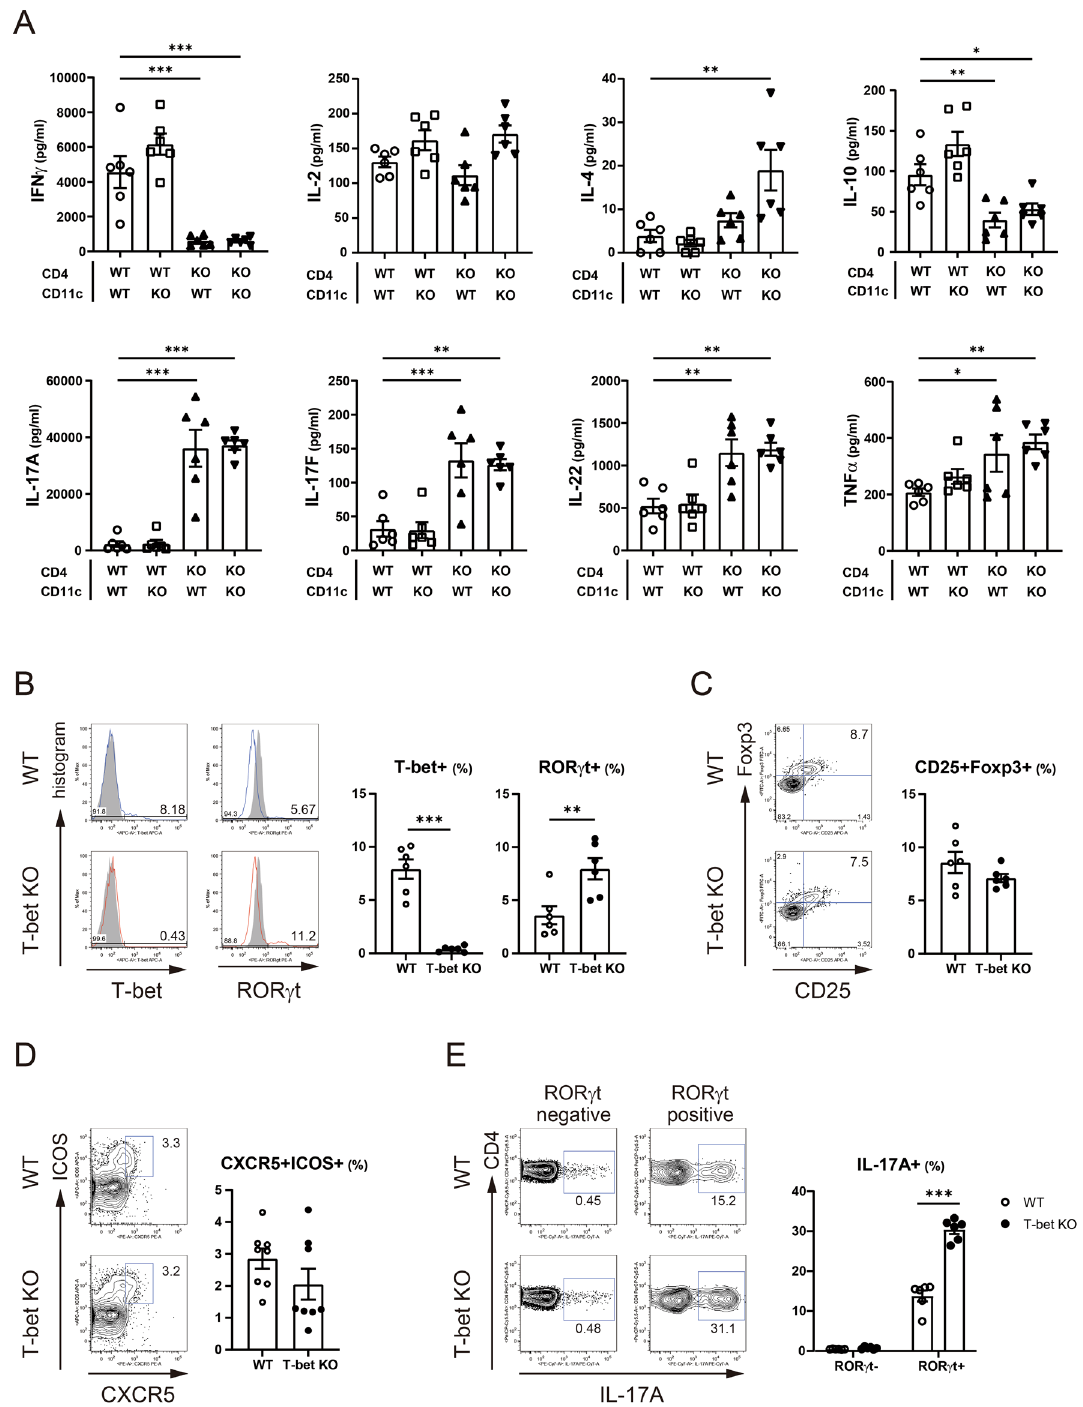
Figure 2. T-bet in CD4 + T cells was critical for the regulation of cytokine production from CD4 + T cells and T-bet suppressed expression and function of RORγt. At day 10 post first CII immunization, CD4 + T cells and CD11c + dendritic cells were purified from the draining LNs of WT mice (n = 6–8) and T-bet KO mice (n = 6–8) and were cultured with 100 µg/mL of denatured CII for 96 h. ( A ) Levels of the cytokines in supernatants were measured using multiplex cytokine assay. The origin of CD4 + T cells or CD11c + dendritic cells is indicated below the bar graphs. ( B – D ) Expression of T-bet, RORγt, Foxp3, CD25, CXCR5, and ICOS in CD4 + T cells was analyzed using FACS. For intracellular staining of cytokines, isolated CD4 + T cells from the draining LNs were stimulated with 50 ng/ml of phorbol myristate acetate and 1 μg/ml of ionomycin. ( E ) IL-17A expression in CD4 + T cells was analyzed using FACS. Data are presented as mean ± SEM. The FACS plots were generated using FlowJo (version 8.8.7, https:// www. flowjo. com/), and the bar graphs were generated using GraphPad Prism 9 (version 9.1.2, https:// www. graph pad. com/ scien tific- softw are/ prism/). Statistical tests: one-way ANOVA with Dunnett’s post hoc test ( A ), Welch’s t test ( B – D ), and Welch’s t test with Bonferroni correction ( E ). (* P < 0.05, ** P < 0.01, *** P <